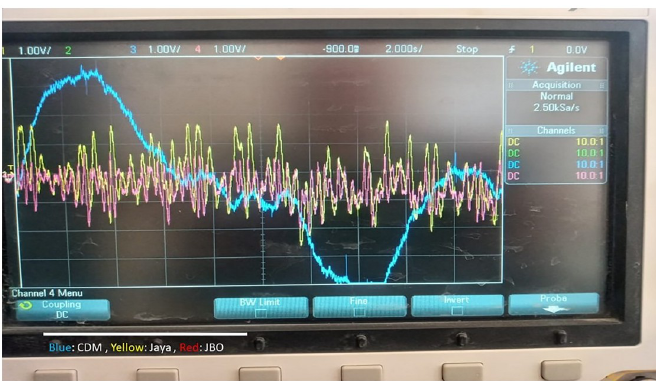
Fig 14. System frequency deviation using real-time simulation with the three investigated